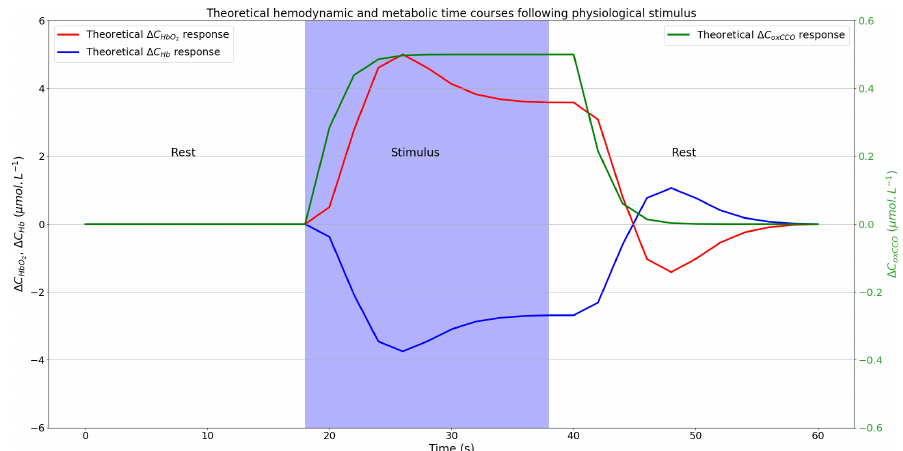
Figure 5. Theoretical ∆ C HbO (in red), ∆ C Hb (in blue), and ∆ C oxCCO (in green) responses following 2 the patient physiological activity. ∆ C HbO and ∆ C Hb are expressed by the left vertical axis. ∆ C oxCCO is 2 expressed by the right vertical axis. The blue rectangle represent the “patient” physiological